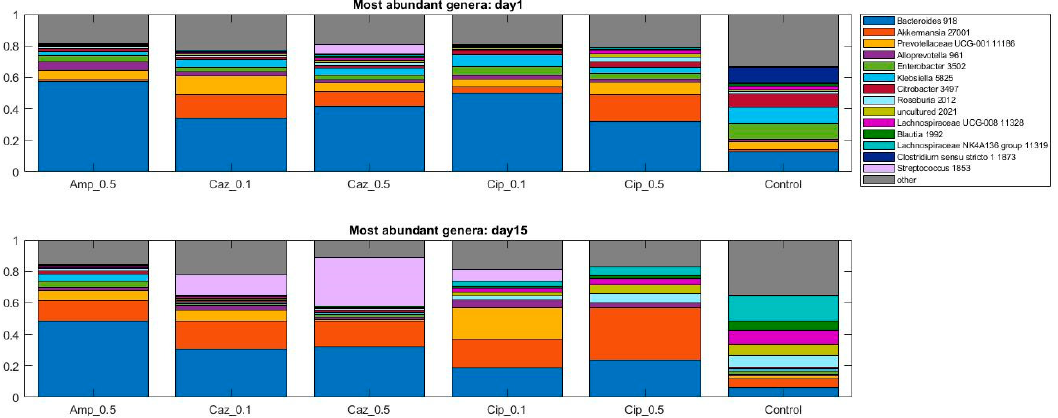
Figure 4. Relative abundances of the fourteen most abundant genera in the dataset over time. Average values of relative abundances at the genus level were calculated for samples from the same treatment groups. Elements are shown if they have at least 5% relative abundance in at least one of the averaged